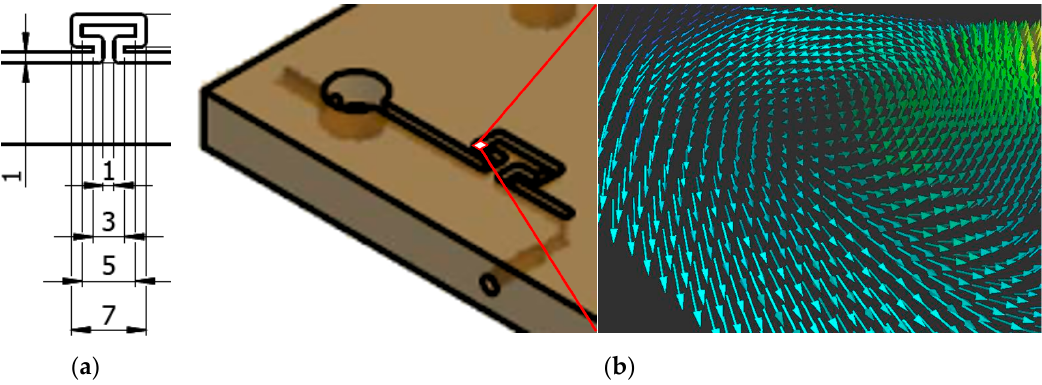
Figure 11. ( a ) Omega-micromixer schematic and dimensions in mm. ( b ) An oblique vortex observed close to one of the sharp corners. Colors indicate the magnitude of the velocity vector.